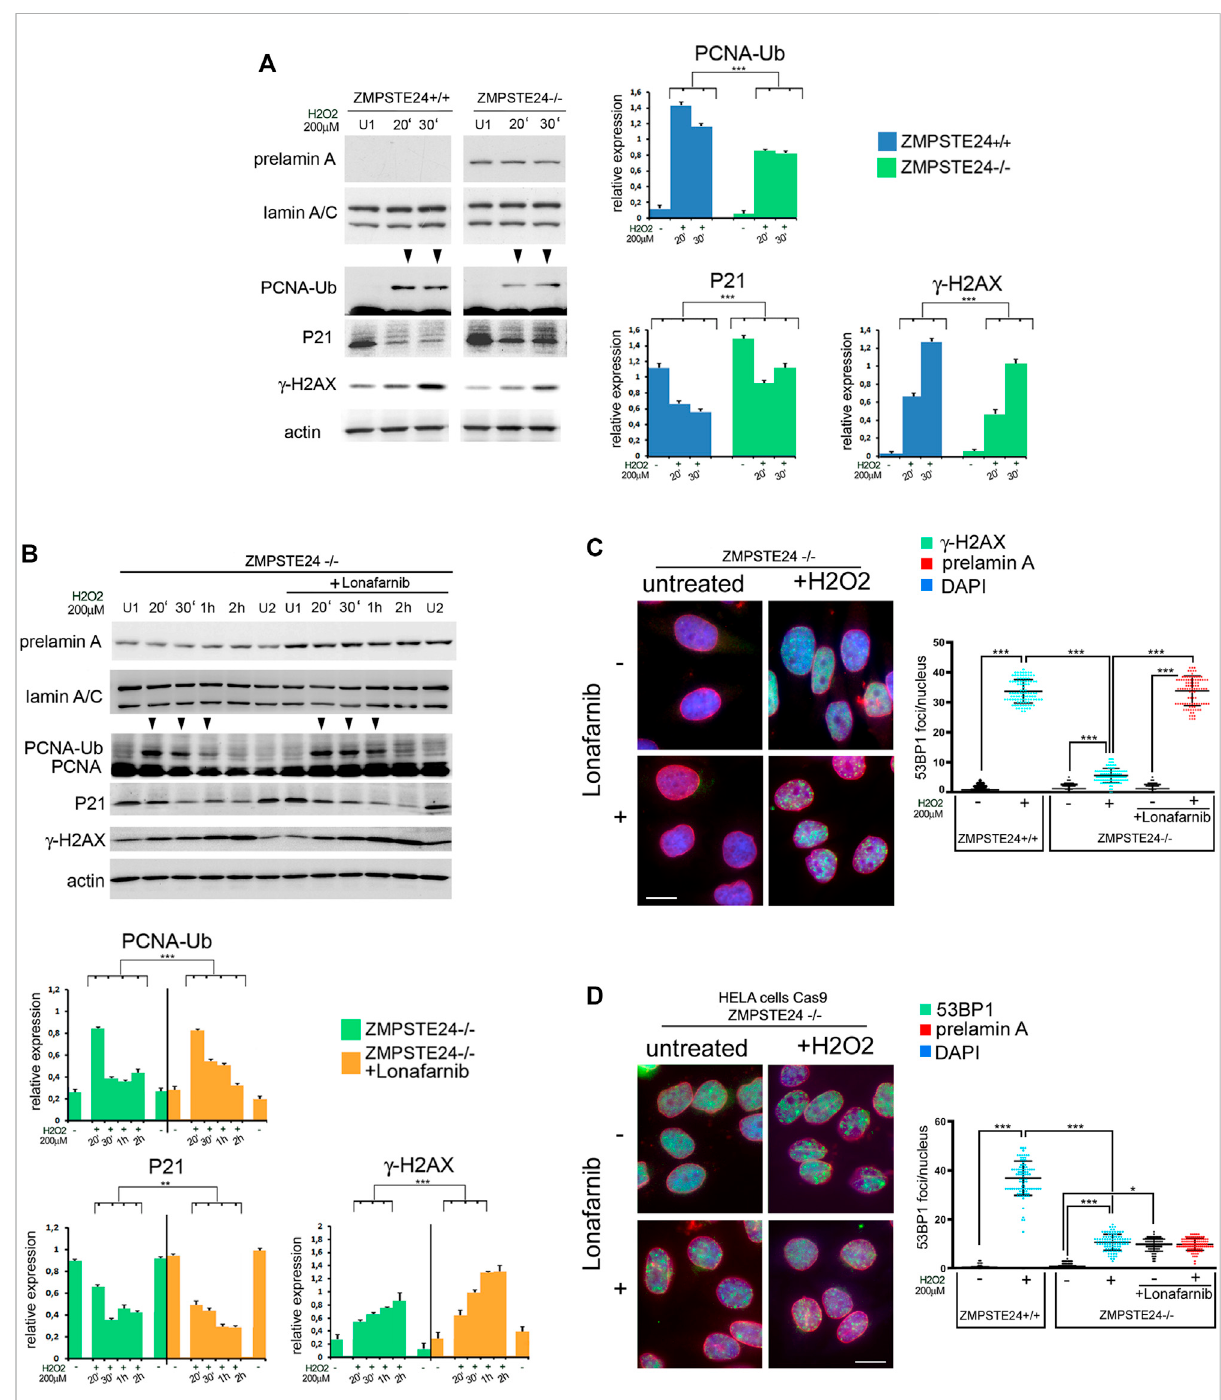
FIGURE 6 Early stage DNA damage response in ZMPSTE24 − / − HeLa cells accumulating farnesylated prelamin A (A) Western blot analysis performed in ZMPSTE24 +/+ (ZMPSTE24 +/+ )andZMPSTE24 − / − HeLacells(ZMPSTE − / − )subjectedtooxidativestress(H2O2).PrelaminA(prelaminA),laminA/C(lamin A/C), mono-ubiquitinated-PCNA (PCNA-Ub), P21 (P21) and gamma-H2AX ( γ -H2AX) bands are shown. Actin was evaluated as a protein loading control. (U1) indicates H2O2-untreated samples collected at 30 min, while 20 ′ and 30 ′ indicates samples collected after 20 and 30 minutes after H2O2 administration respectively. Arrowheads indicate time points in which the mono-ubiquitinated form of PCNA was detectable. Statistical analysis of mean values obtained from triplicate western blot densitometry (relative densitometry normalized to loading controls) was performed by Student ’ sttest.Signi fi cantlydifferentvaluesareindicatedbyasterisks:***= p < 0.001. (B) WesternblotanalysisperformedinZMPSTE24 − / − Helacells (ZMPSTE24 − / −